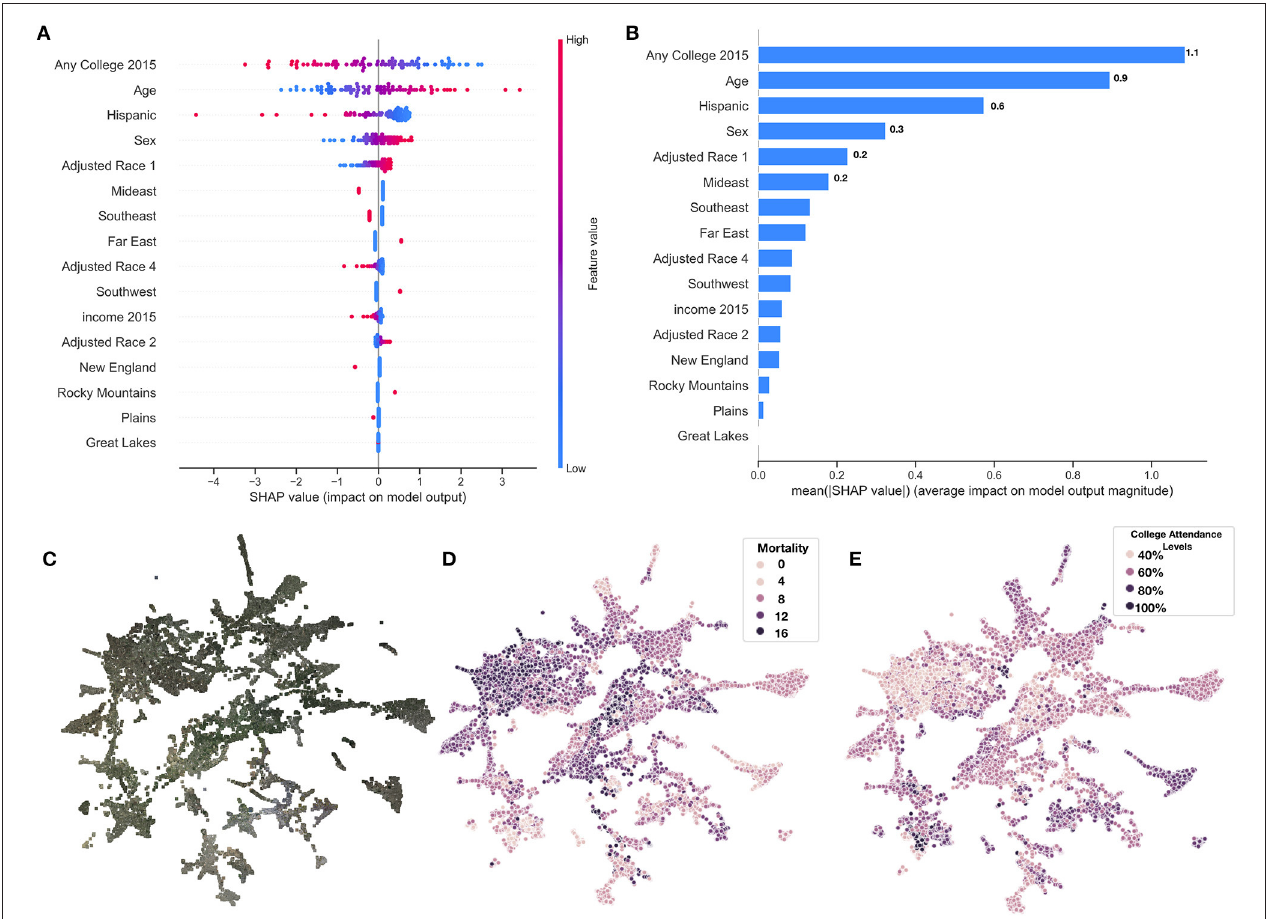
FIGURE 5 | SHAP summary of covariate predictors and image embeddings. (A) SHAP summary plot for covariate model evaluated on test set, covariates ranked by feature importance; (B) SHAP rankings of overall importance of covariates; (C–E) 2-D UMAP plot of image features derived from images using deep learning model: (C) actual images overlaying 2-D coordinates; (D) colored by true county mortality; (E) colored by average college attendance; we note here that our model has been explicitly trained to associate image features with mortality; the separability of college attendance over the image features is an artifact of the association between education status and